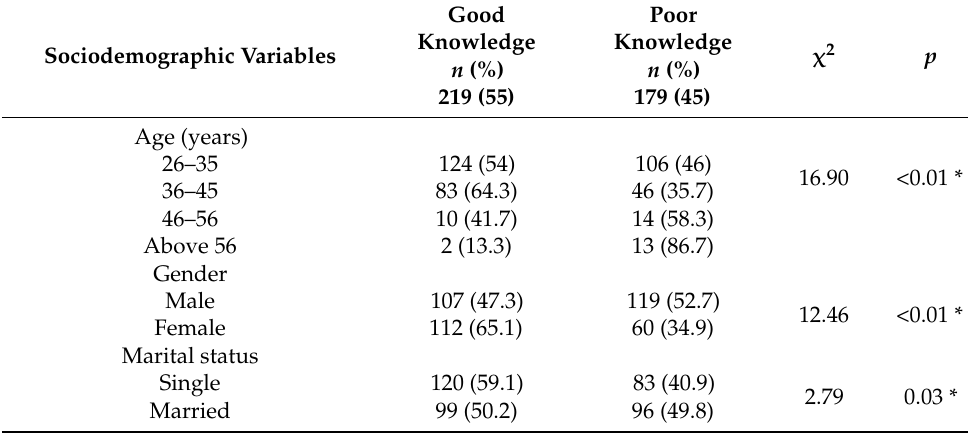
Table 3. Association between sociodemographic variables and knowledge score among Saudi physi- cians who participated in the study ( n =